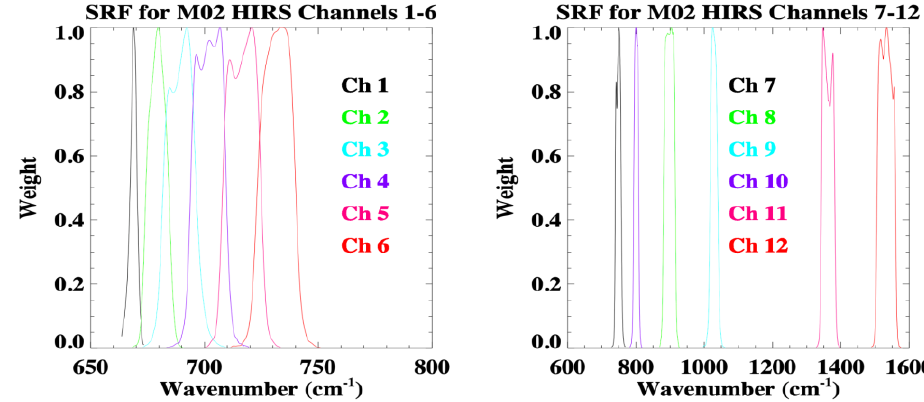
Figure 1. SRFs for MetOp -2 HIRS channels 1 – 6 ( left panel ) and 7 – 12 ( right panel